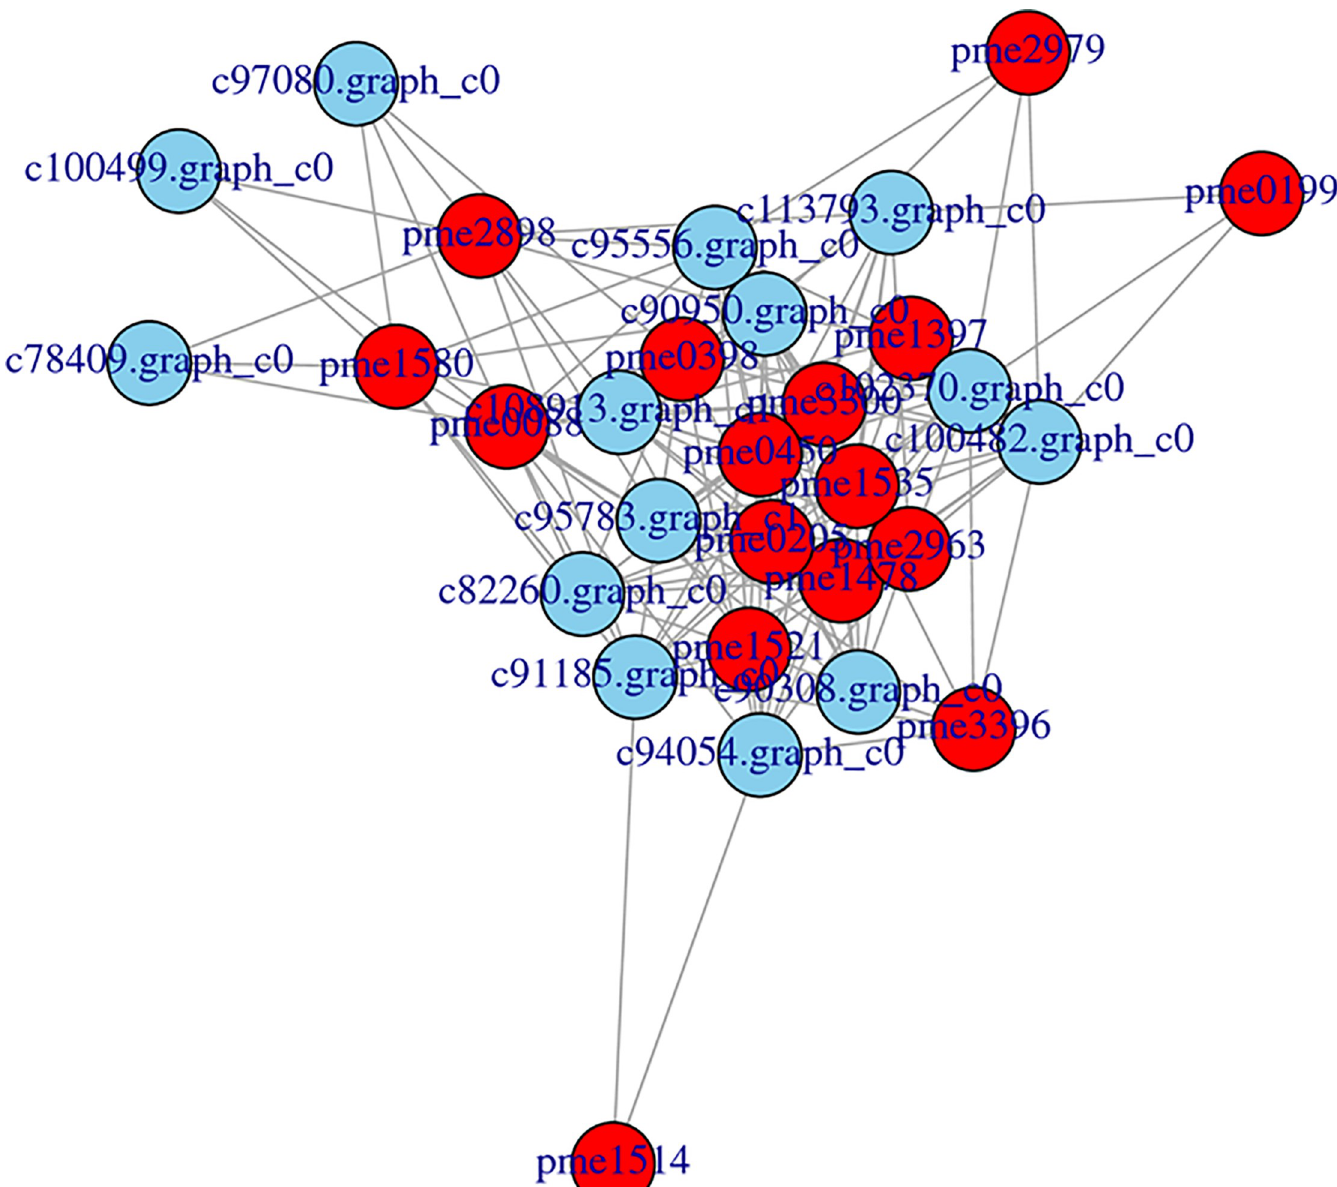
Fig 8. Connection network between regulatory genes and anthocyanin-related metabolites. The networks between metabolites and transcripts were visualized with Cytoscape software (version 2.8.2).